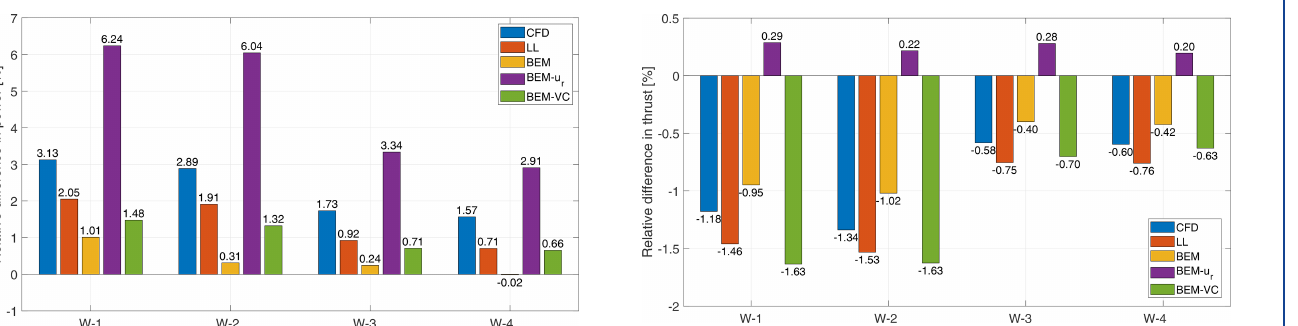
Figure 17. The relative difference of power of the dihedral blades without cone compared to the baseline straight blade. The opera- tional condition is with a uniform wind speed of 8ms − 1 , rotational speed of 0.855rads − 1 and zero cone angle.